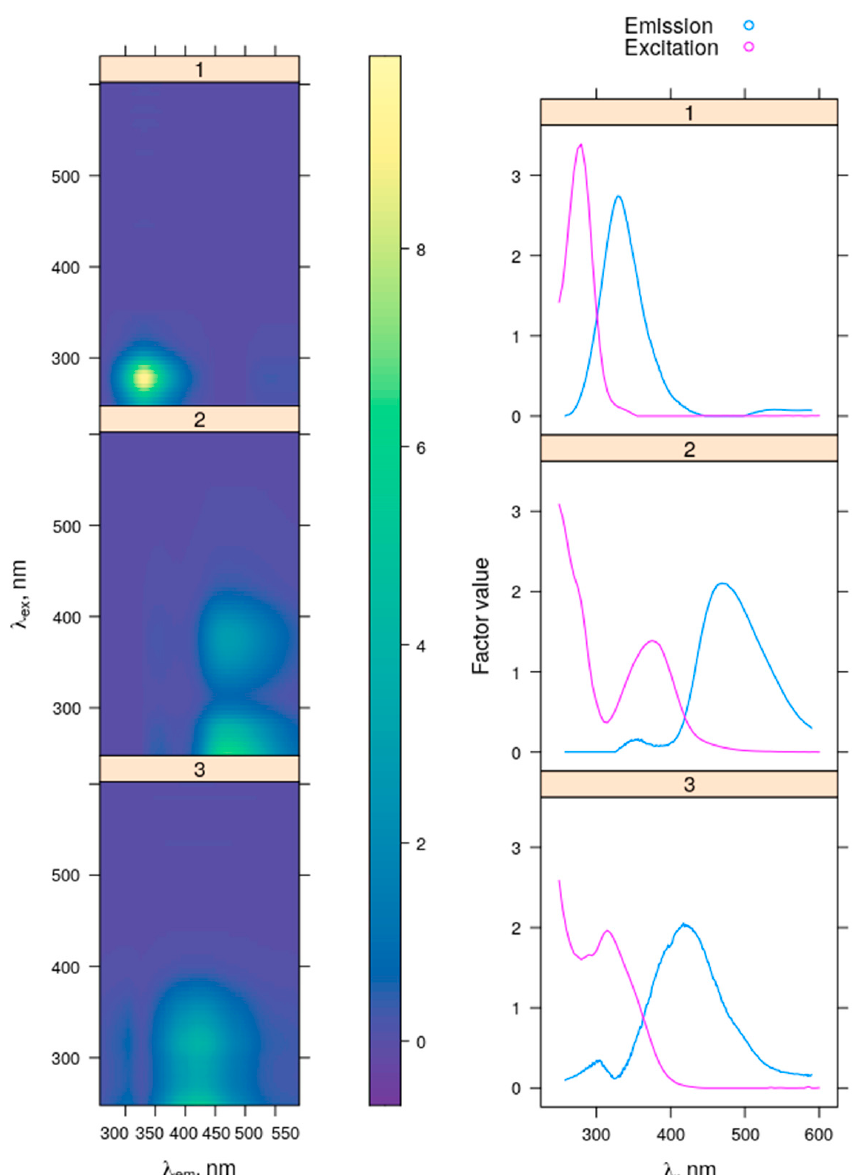
Figure 10. EEMs ( left panel ), excitation and emission spectra ( right panel ) for each identified PARAFAC component.